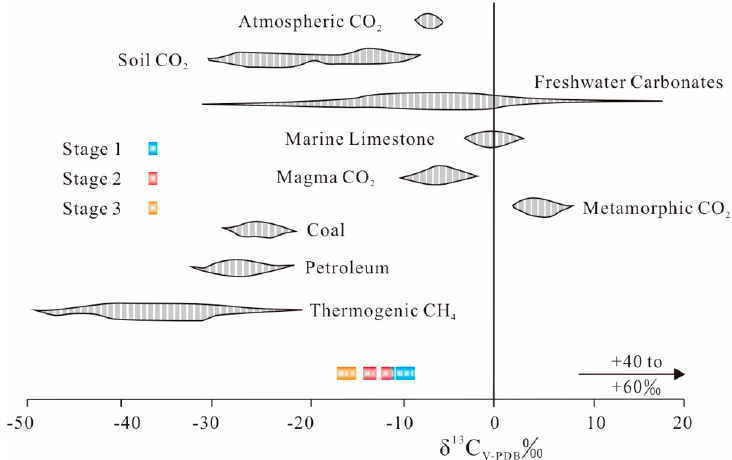
Figure 9. δ 13 C values of quartz and fluorite from the Kuergasheng Pb–Zn deposit compared with values from important geological reservoirs (data from Clark and Fritz